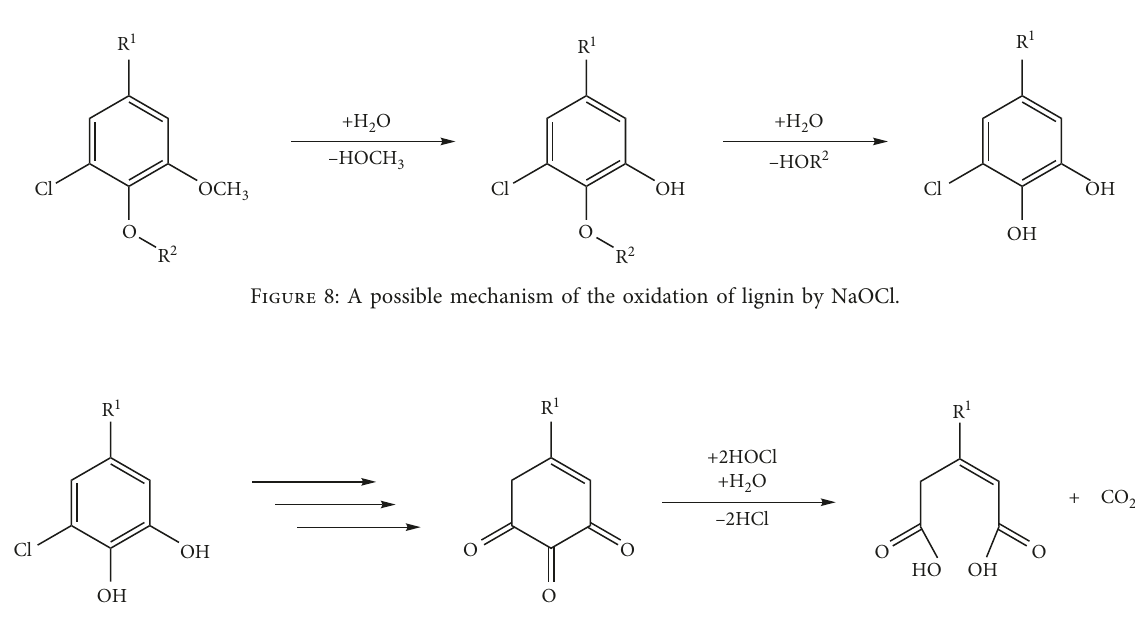
Figure 9: A possible mechanism of the oxidation of lignin by NaOCl. Table 4: The mechanical properties of WPU elastomers. Blank WPU elastomer LPCA-WPU